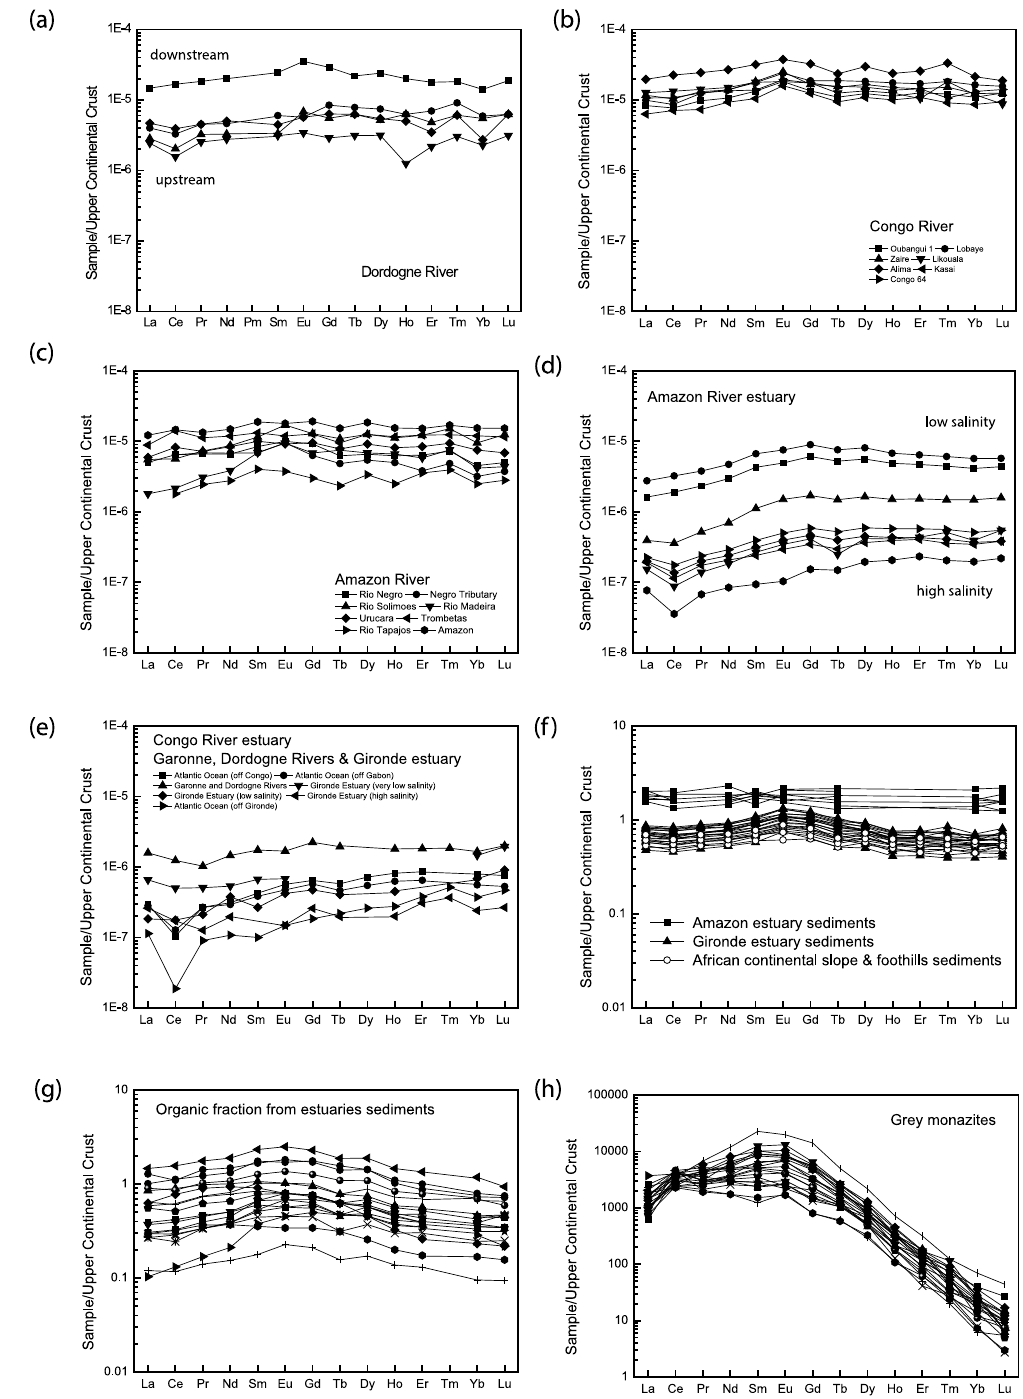
Figure 1. Upper continental crust (UCC)-normalized REE patterns in samples from ( a ) Dordogne River basin 27 , ( b ) Congo River basin 28 , ( c ) Amazon River basin 29 , ( d ) Amazon River estuary 21 , ( e ) Congo River estuary (unpublished results from Germain Bayon) and Dordogne, Garonne Rivers and Gironde estuary 31 , ( f ) African continental slope and foothill sediments 33 , Amazon estuary sediments 34 and Gironde estuary sediments 35 , ( g ) organic fraction from estuaries sediments 20 and ( h ) Ordovician organic rich grey monazites (each sample corresponds to a different monazite) 30 . UCC values are from McLennan 36